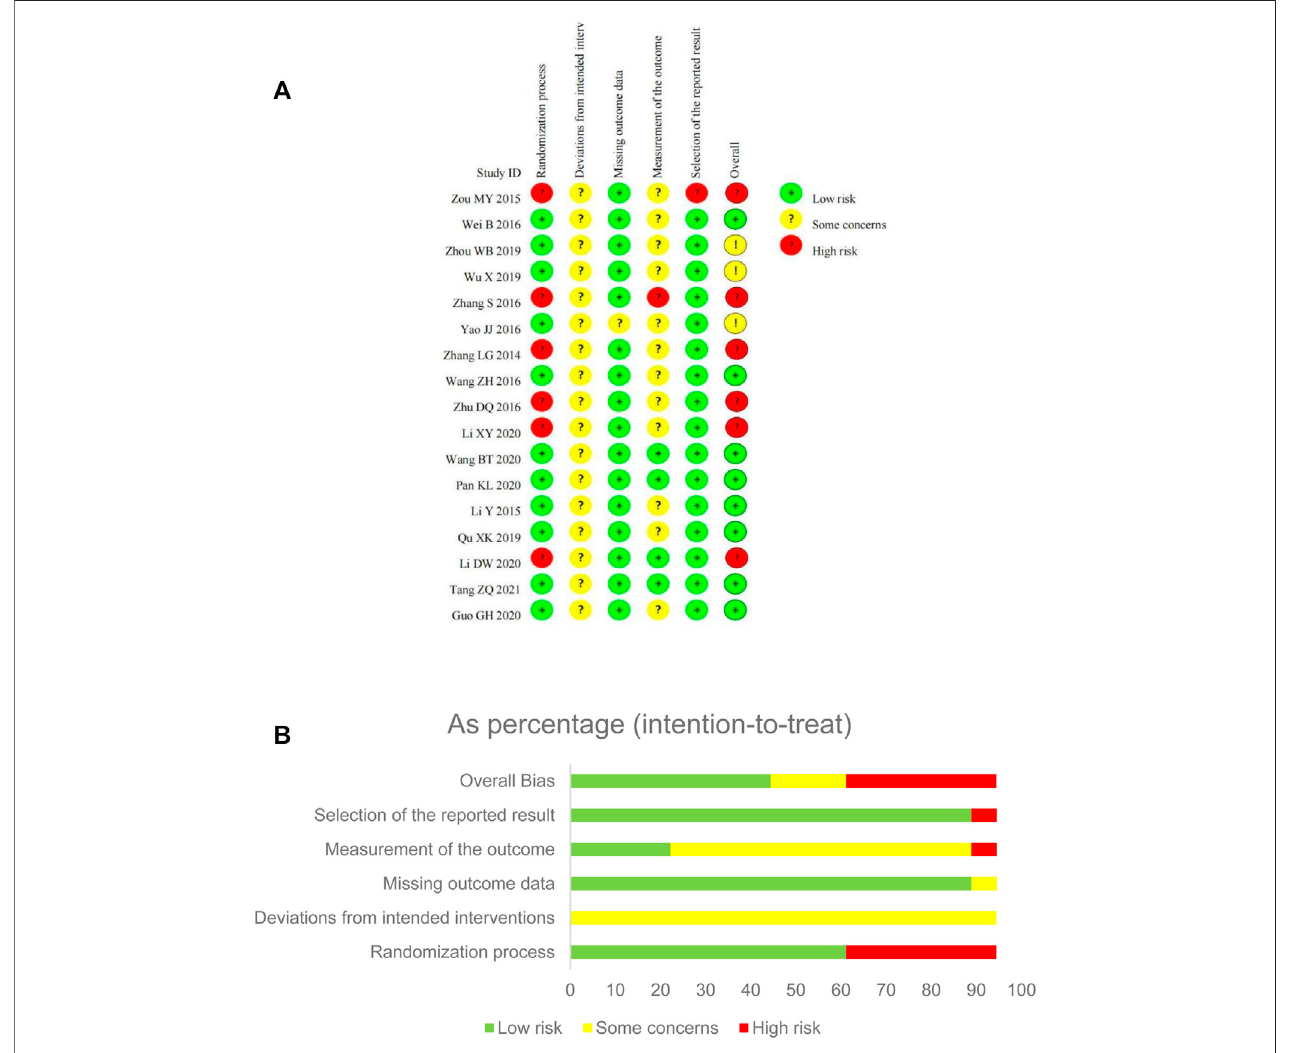
FIGURE 2 | Risk of bias assessment for eligible studies. (A) Risk of bias summary; (B) Risk of bias graph.